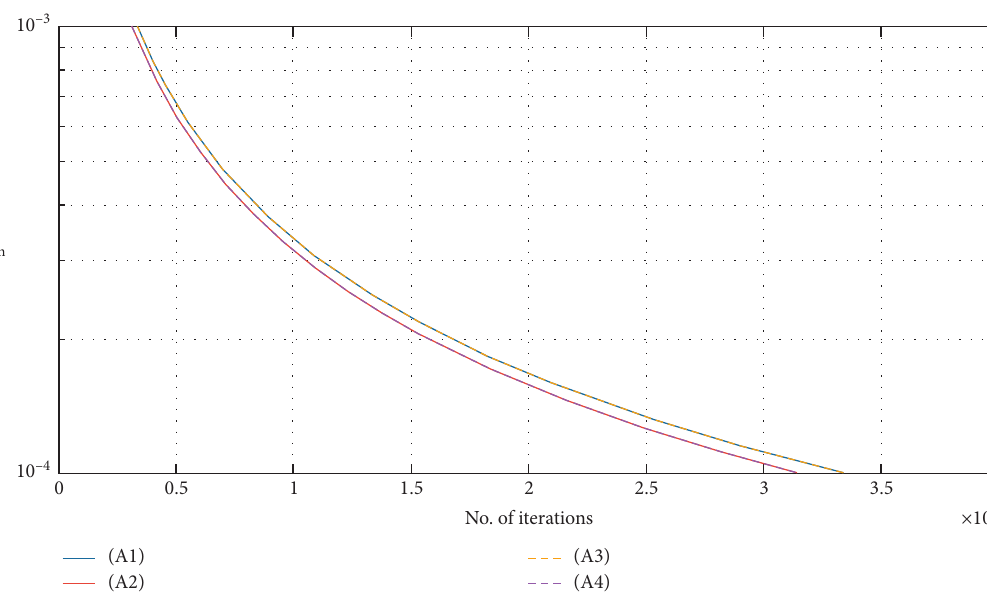
(− 2 , 1 ) T . n with the initial point